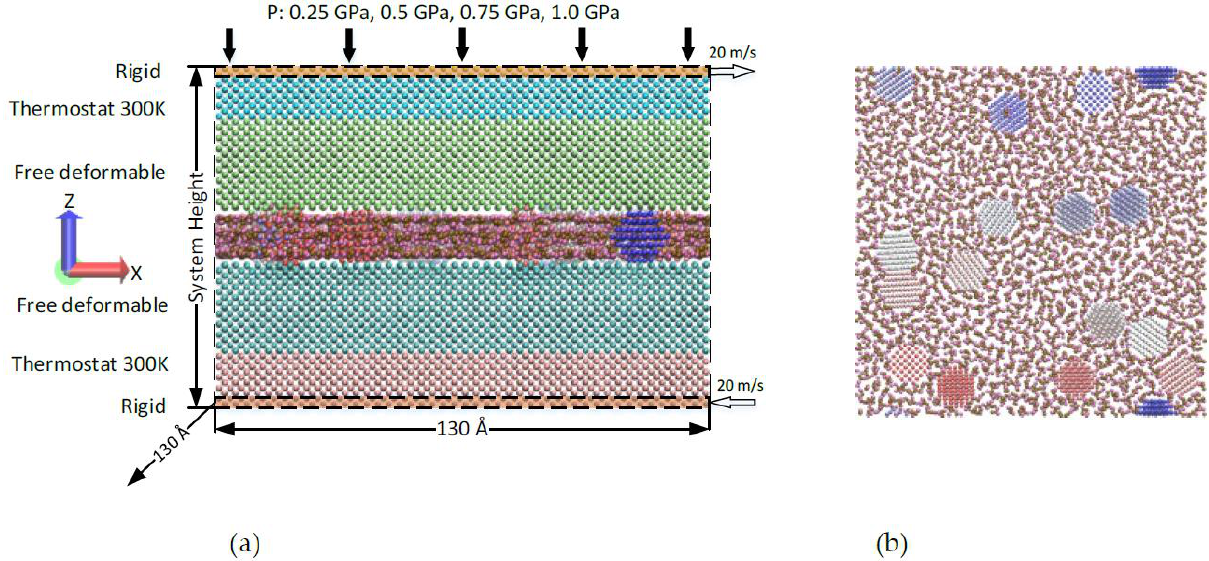
Figure 1. ( a ) A typical molecular structure showing C4-alkane and 16 nanoparticles were confined between the iron walls and ( b ) top view of nanoparticles and C4-alkane fluid. Normal load (P) is only applied on the upper rigid region, but the lower rigid region is fixed in the Z direction. These white arrows exhibit the sliding direction at a speed of 20 ms/s imposed on rigid regions.